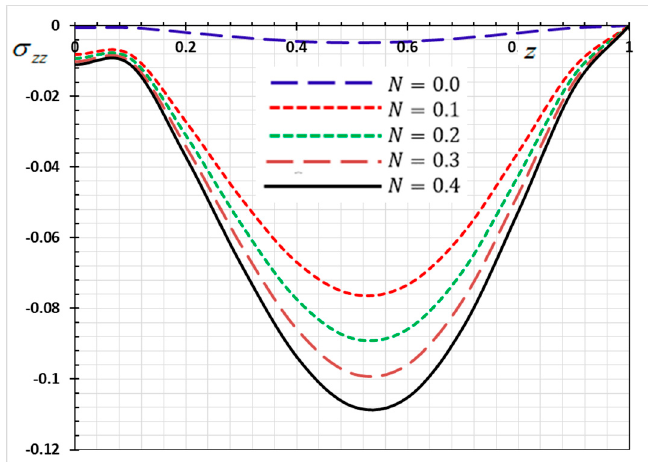
Figure 11. Variation of Thermal stress σ zz versus z for di ff erent gradient coe ffi cient N